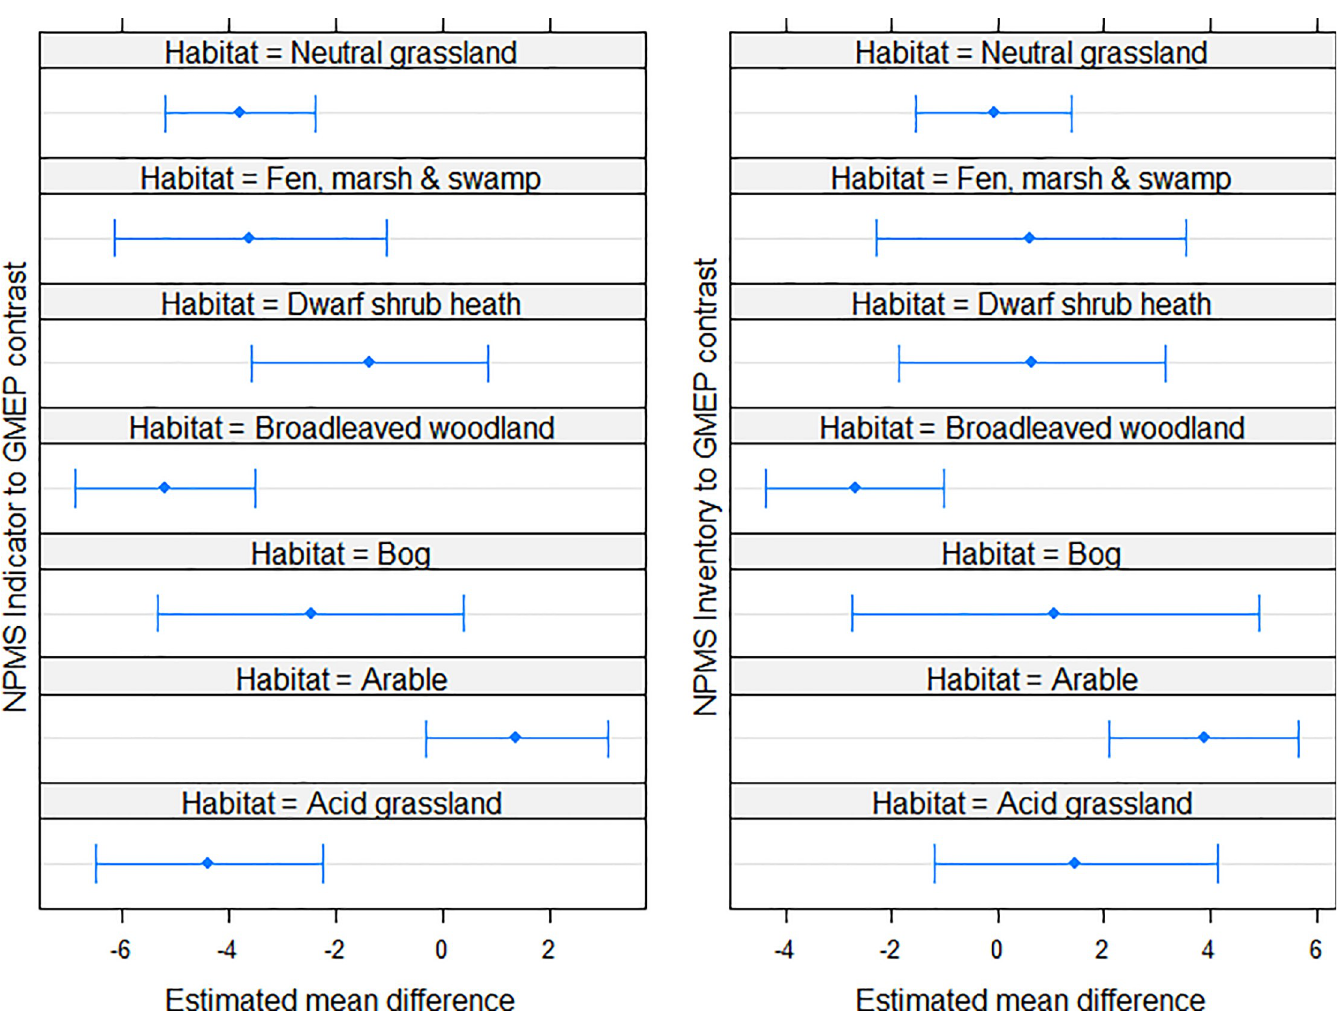
Fig 9. Comparisons of NPMS indicator and inventory richness in Wales compared to GMEP survey data. Broad habitat-based contrasts for NPMS indicator and inventory plots compared to their GMEP comparators (estimated mean difference with 95% confidence intervals). Note that all comparisons are based solely on presence of NPMS indicator species, irrespective of plot type. Such a constraint ensures that records made in all plots are drawn from the same list of plant species; all differences should therefore be due to effort or bias, rather that systematic differences in the species sought by recorders.